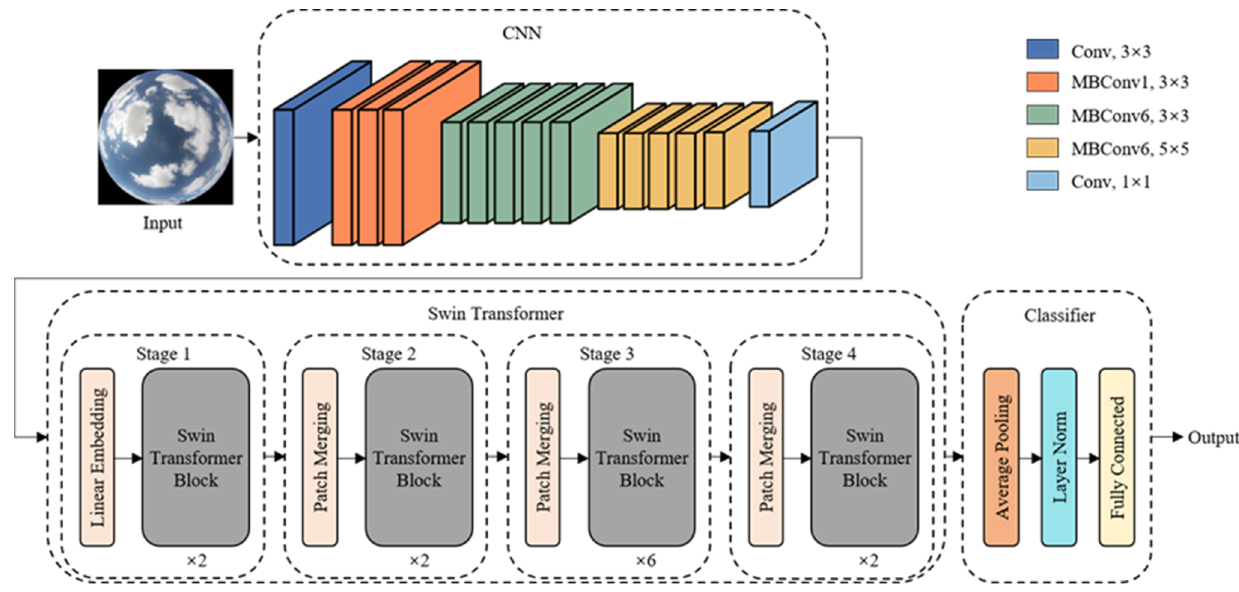
Figure 1. O verall architecture of the proposed method. Figure 1. Overall architecture of the proposed method. Table 1. The details of the proposed model. Table 1. The details of the proposed